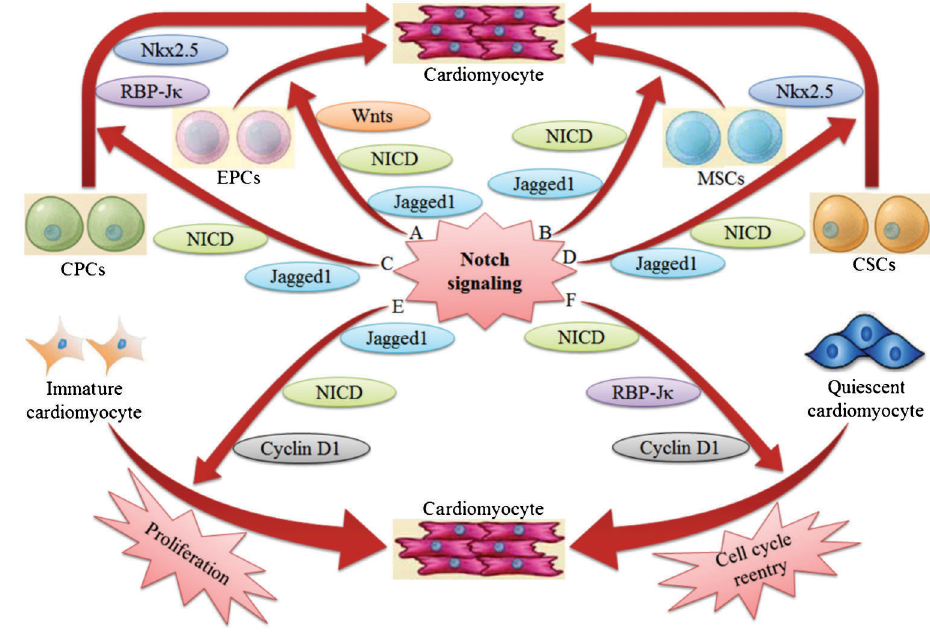
Figure 3. Regulatory role of Notch signaling for myocardial regeneration. A , Notch signaling amplifies EPC differentiation into cardiomyocytes through Jagged 1, NICD and Wnts. B , MSCs enhance cardiomyocyte proliferative capacity through Jagged 1 and NICD. C , Notch signaling promotes the differentiation of CPCs into cardiomyocytes through Jagged 1, NICD, RBP-J k , and Nkx2.5. D , Notch signaling expands the proportion of CSCs differentiating into cardiomyocytes through Jagged 1, NICD, and Nkx2.5. E , Notch 1 signaling stimulates proliferation of immature cardiomyocytes through Jagged 1, NICD, and cyclin D1. F , Notch signaling activates cell cycle reentry of quiescent cardiomyocytes through NICD, RBP-J k , and cyclin D1. EPCs: endothelial progenitor cells; NICD: Notch intracellular domain; Wnts: Wnt signaling; MSCs: mesenchymal stromal cells; CPCs: cardiac progenitor cells; RBP-J k : recombination signal binding protein for immunoglobulin J k region; Nkx2.5: NK2 homeobox 5; CSCs: cardiac stem